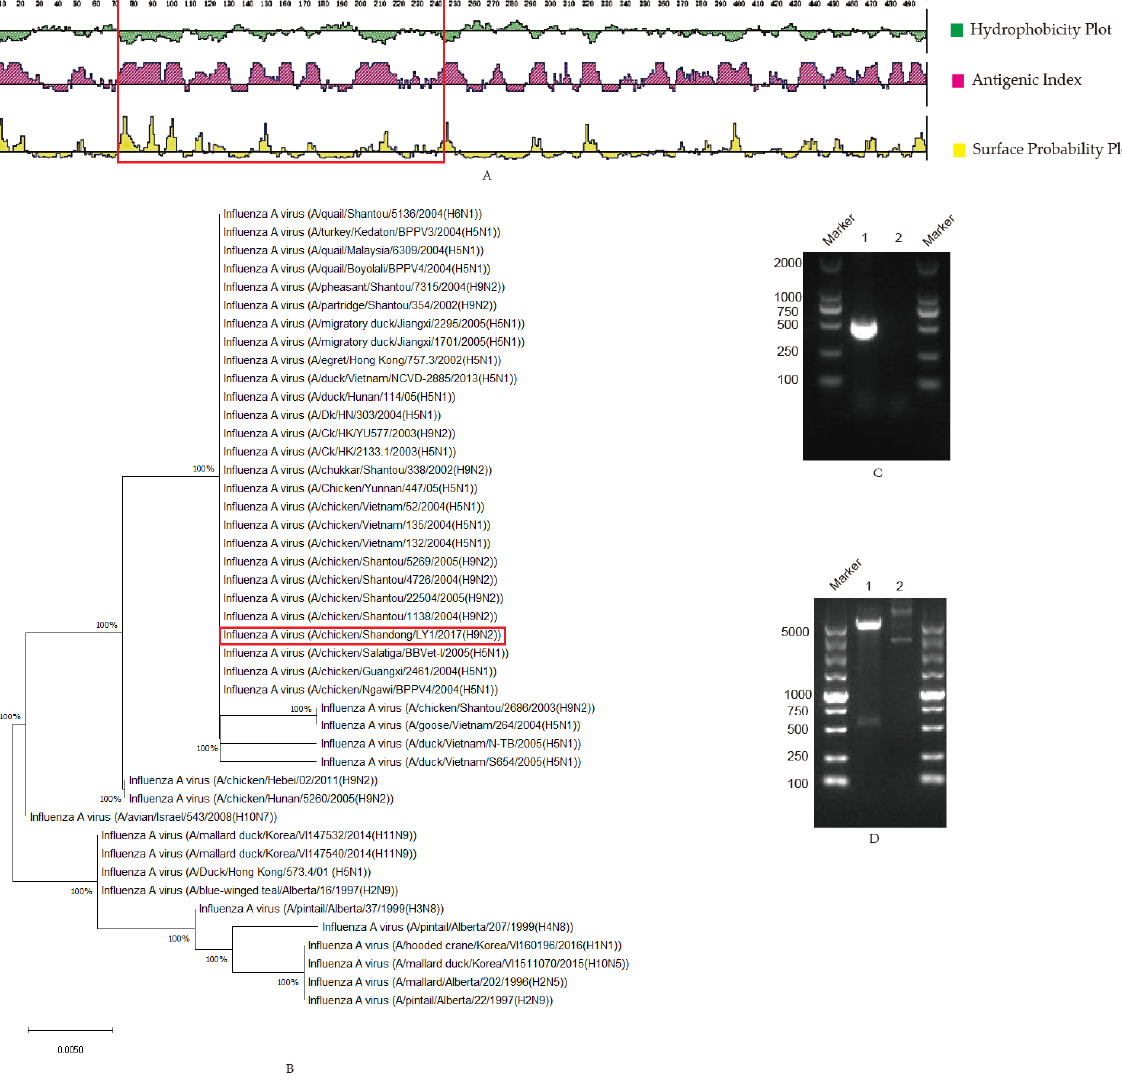
Figure 1. Selection and prokaryotic expression of NP truncated genes: ( A ) The structural character- istics of NP protein. Hydrophilicity, antigenicity and surface probability analysis of NP proteins were performed with the software Protean, in which the region marked in the red box was the se- lected fragment (71–243 AA); ( B ) Phylogenetic tree of the truncated NP protein. The homologies